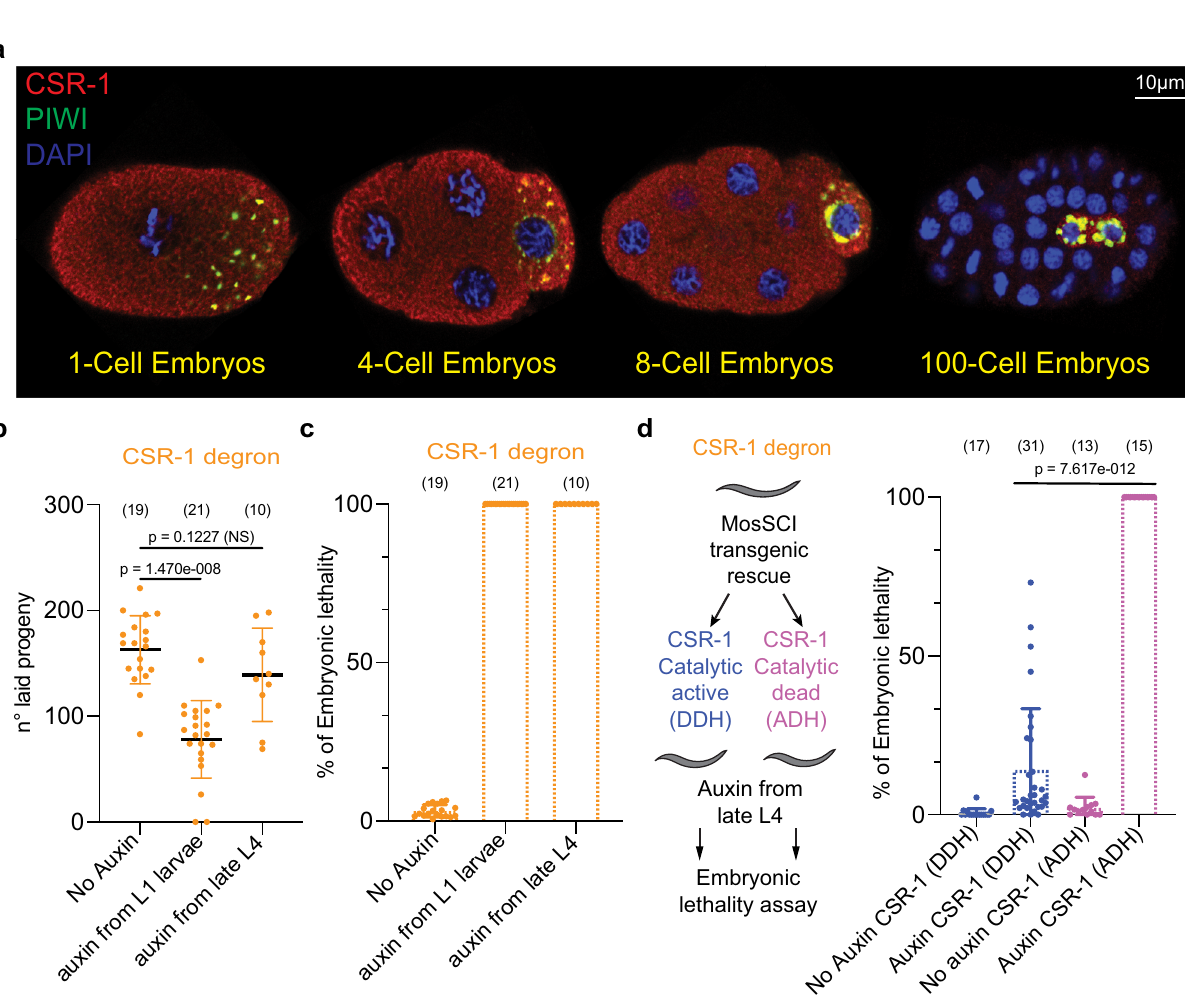
Fig. 1 CSR-1 localizes to the cytoplasm of somatic blastomeres and its slicer activity is essential for embryonic development. a Immunostaining of CSR-1 and PIWI in 1-, 4-, 8-, and more than 100-cell embryos of a 3xFLAG::HA::CSR-1 CRISPR-Cas9 strain, using anti-FLAG and anti-PRG-1 antibodies. DAPI signal is shown in blue. Scale bars represent 10 µ m. b Brood size assays of CSR-1 degron strains with and without Auxin. The data points correspond to the number of living larvae from individual worms. Data are presented as mean ±SD. Two-tailed P values were calculated using Mann – Whitney – Wilcoxon tests. The sample size n (worms) is indicated in parentheses. c Percentages of embryonic lethality from the brood size experiment shown in b , measured as the percentage of dead embryos versus the total number among laid embryos. Data are presented as mean± SD. The sample size n (worms) is indicated in parentheses. d Percentage of embryonic lethality in CSR-1 degron strains complemented with single-copy transgenic expression of CSR-1 with (ADH) or without (DDH) mutation in the catalytic domain. The percentage of embryonic lethality is calculated by dividing the number of dead embryos by the total number of laid embryos. Dots correspond to the percentages of embryonic lethality from individual worms. Data are presented as mean ±SD. Two-tailed P values were calculated using Mann – Whitney – Wilcoxon tests. The sample size n (worms) is indicated in parentheses. The graphical representation of the experiment is shown on the left. Source data are available